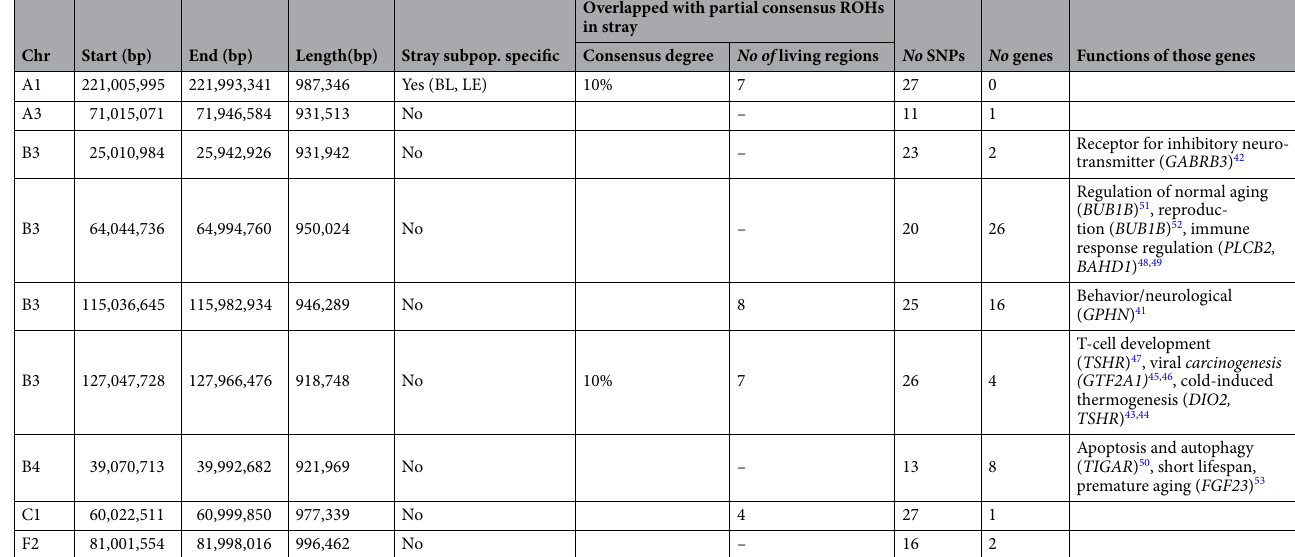
Table 7. Unique selective events identified by comparing of d i -summary statistics of stray with household, OSH and SIAM. For each of the selective events, the chromosomal location, the estimated region length, the number of SNPs and the number of genes located in the respective region, as well as the functional annotation of these genes are given. For selective events that are specific to a subpopulation of stray (Stray subpop, specific) and overlap with a partial consensus ROH for stray, the degree of consensus level (%) and the number of residential regions from which stray cats were collected are given. BL Bleckede, LE Leonberg.